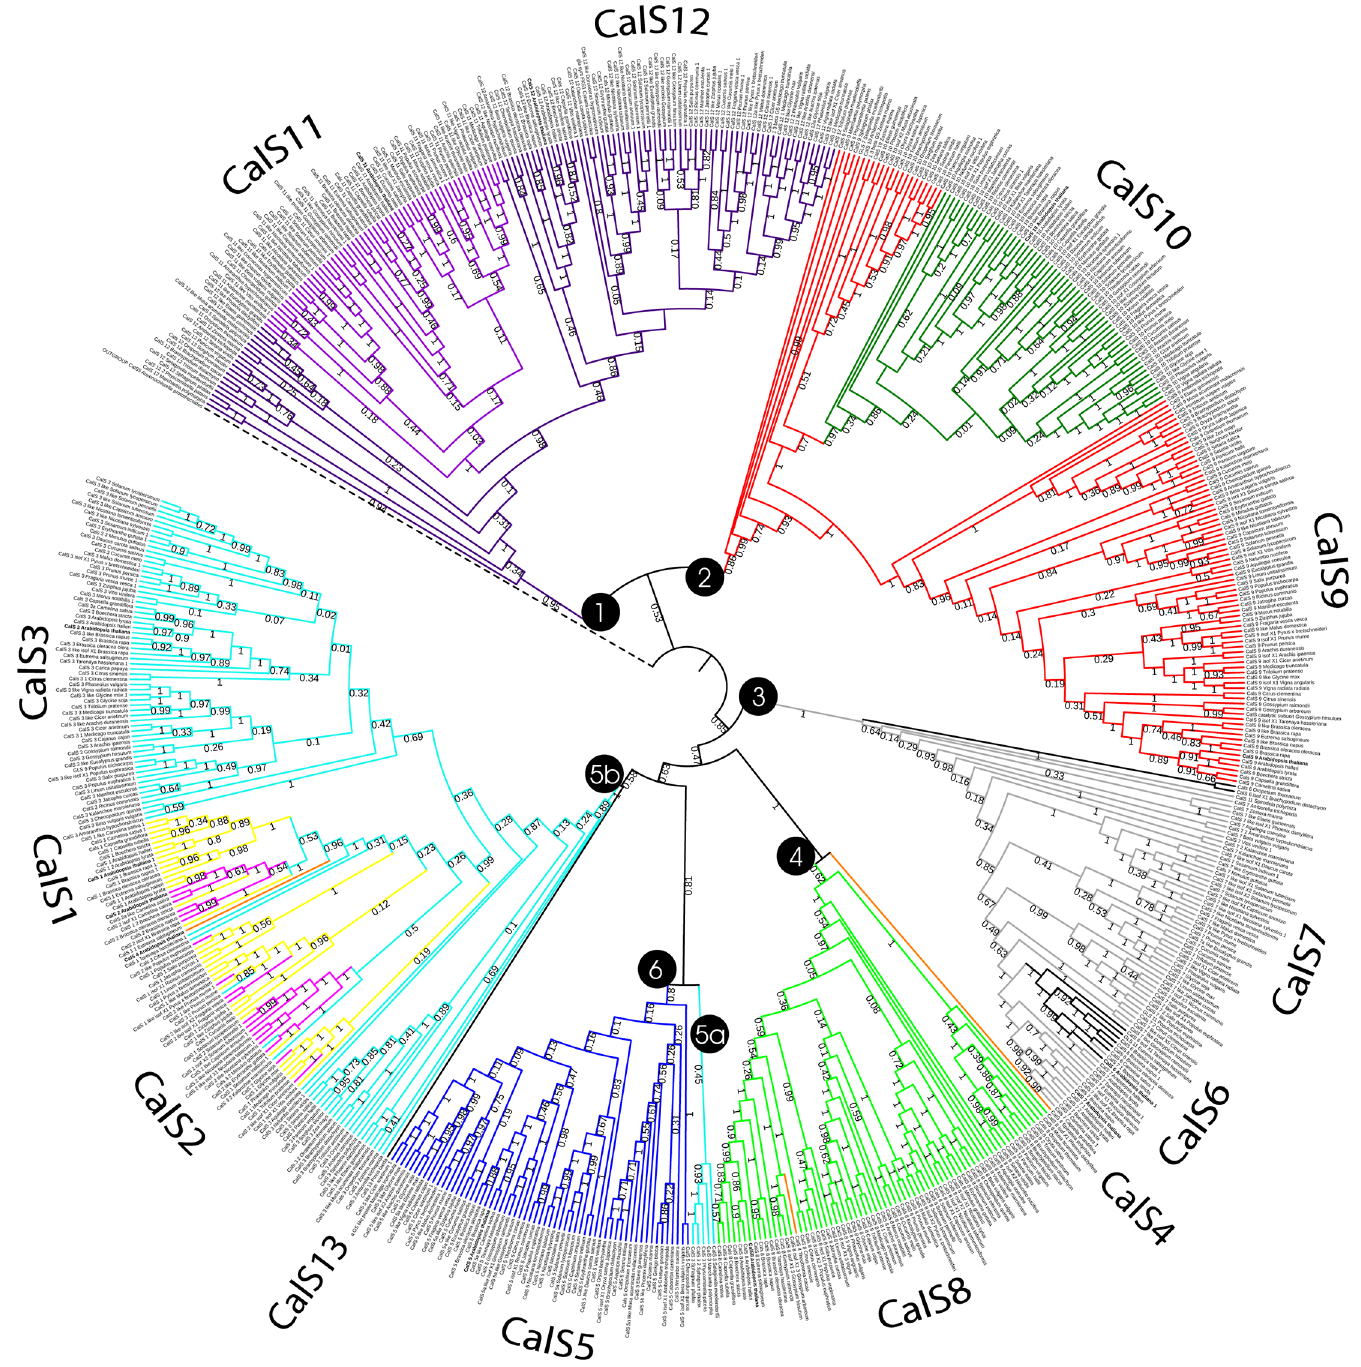
Fig 6. Callose synthase phylogeny in terrestrialplants inferred using maximum parsimony. The tree is rooted by green alga Auxenochlorella protothecoides representing one of possible outgroup for terrestrialplants. The most parsimonioustree with length90012, CI = 0,223978, RI = 0,828990 is shown. The data contains655 protein sequencesand 4970 positionsin the final dataset. Bootstrap support values (cid:21) 50% are shown next to the branches. Numbersin circles indicatemain clades describedin the text.